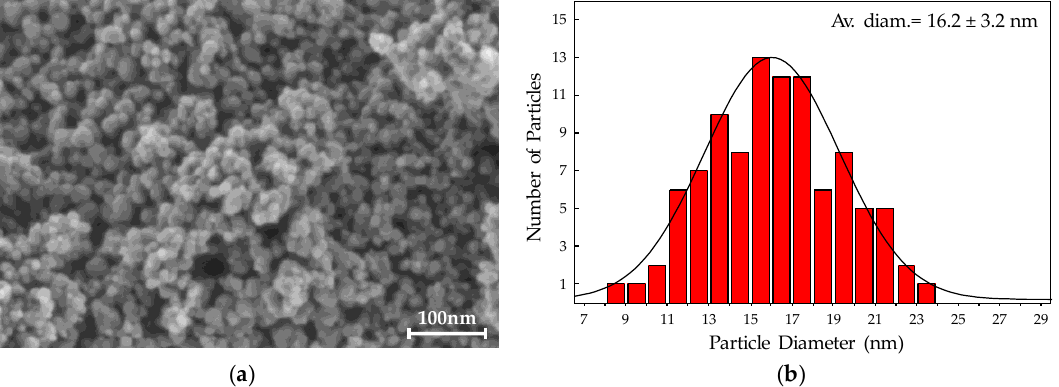
Figure 2. ( a ) Field emission scanning electron microscopy (FESEM) micrograph of magnetite solid precipitated from a reflux synthesis at 80 °C using a nominal Fe 3+ /Fe 2+ molar ratio of 4. Image conditions: in-lens mode, work distance 2.7 mm, energy selective backscattered (EsB) grid of 300 V and electron high tension (EHT) of 1 kV. ( b ) Statistic distribution of particle diameter from several FESEM micrographs of the magnetite solid shown in (a).